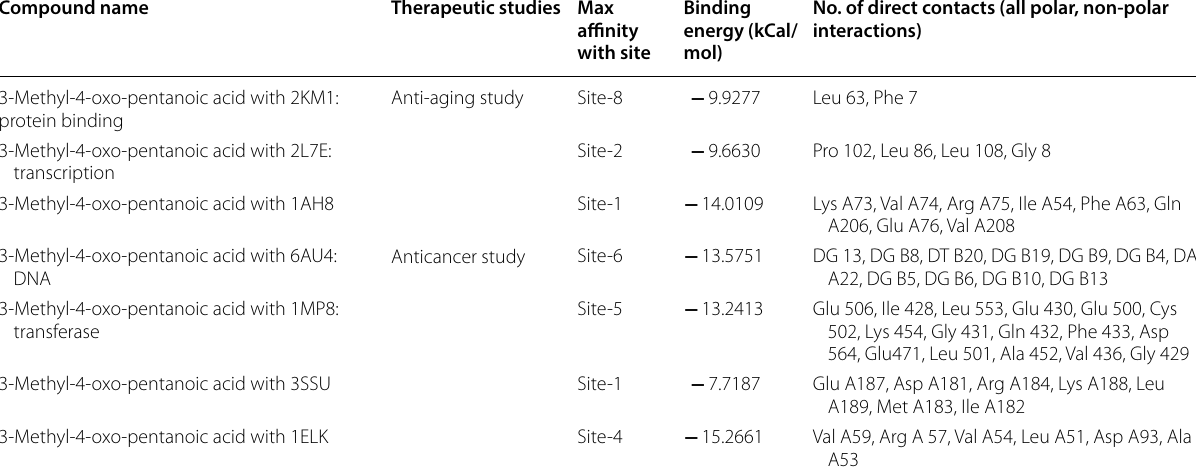
Table 1 In silico therapeutic studies of the compound with different targets in respect of binding energy and no. of direct contacts (all polar, non-polar